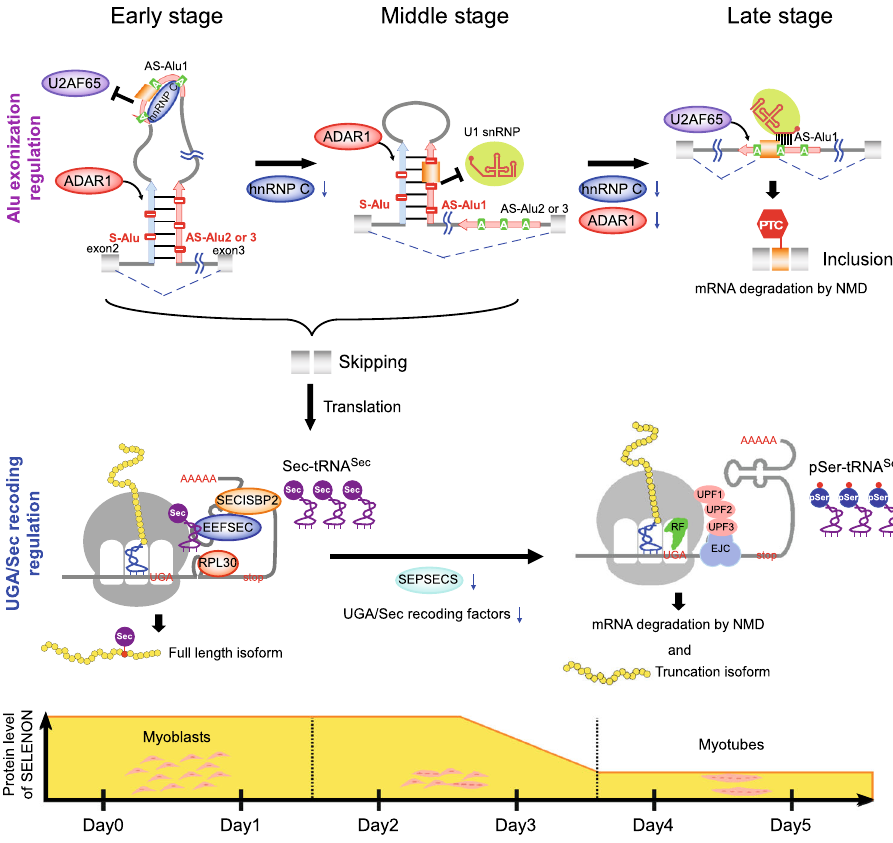
Fig. 6 Mechanisms underlying post-transcriptional regulation of SELENON expression during myoblast differentiation. At the early stage, hnRNP C binds to AS-Alu1 of SELENON pre-mRNA and inhibits U2AF65 recognition, thereby suppressing Alu exonization. At the middle stage, the level of hnRNP C decreases, thereby releasing AS-Alu1, which forms a long double strand with S-Alu to be recognized by ADAR1. ADAR1 edits AS-Alu1, including the 5 ′ SS of the Alu exon, thereby inhibiting U1 snRNA recognition to suppress Alu exonization. Sequential regulation of Alu exonization by the two consecutive mechanisms maintains SELENON expression from the early-to-middle stage of differentiation. At the late stage, the level of ADAR1 also decreases, thereby promoting Alu exonization and generating aberrant mRNA with PTC, followed by degradation by NMD. Moreover, at the middle-to-late stage, the levels of SEPSECS and other UGA/Sec recoding factors decrease to downregulate Sec-tRNA Sec formation, thereby suppressing UGA/Sec recoding. As a result, SELENON mRNA is subjected to degradation (probably by NMD) or translation to yield the truncated isoform of